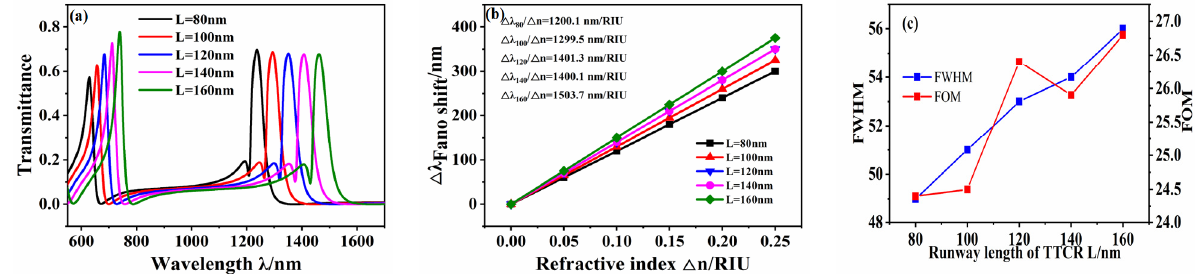
Figure 6. ( a ) Transmission spectrum of waveguide structure under different L . ( b ) Sensitivity fitting curve. ( c ) Fitting curve of FWHM and FOM values.